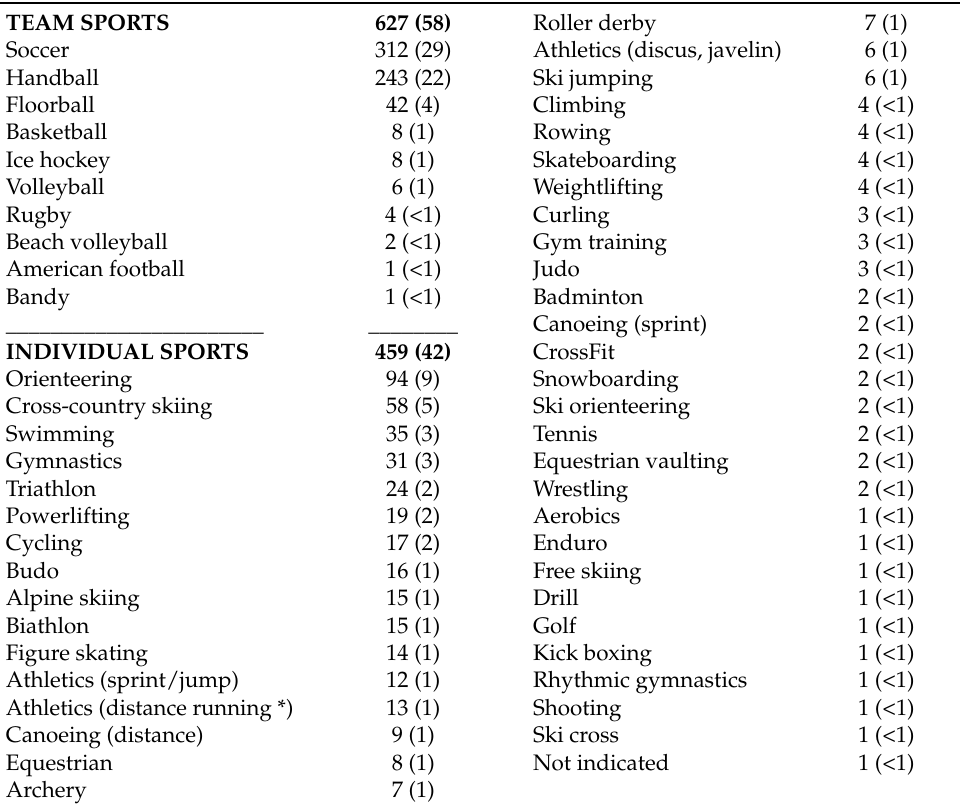
Table 1. The different sports represented, n (percentage) of participants in each sport. Athletes from team sports, n = 627 (58) and athletes from individual sports, n = 459 (42).